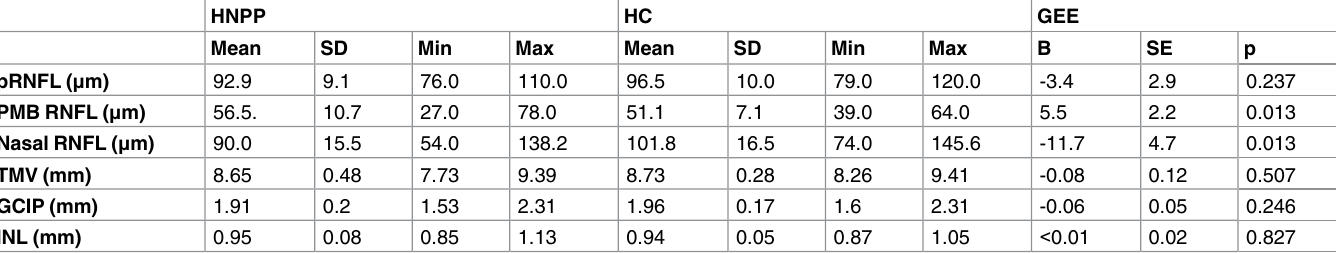
Table 2. OCT measurements.